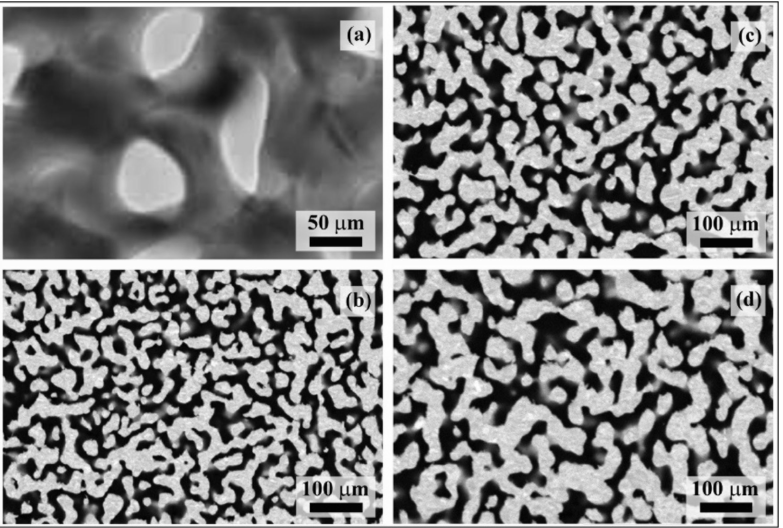
Figure 1. ( a ) TEM and ( b ) SEM micrographs of the NP Au foam obtained by dealloying. SEM micrographs refer to NP Au structures annealed for ( c ) 2 h and ( d ) 5 h.